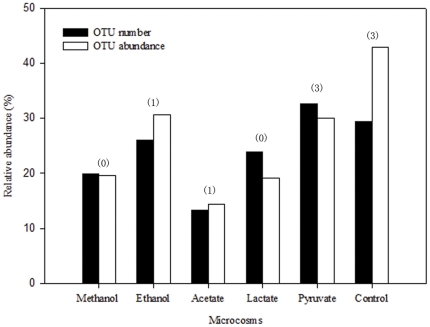
The percentages of the unique OTU number and relative abundance to the total OTU number and abundance detected in the defined microcosm.The numbers of the predominant OTUs whose relative abundance were higher than 1.0% were presented above the bars in parentheses.